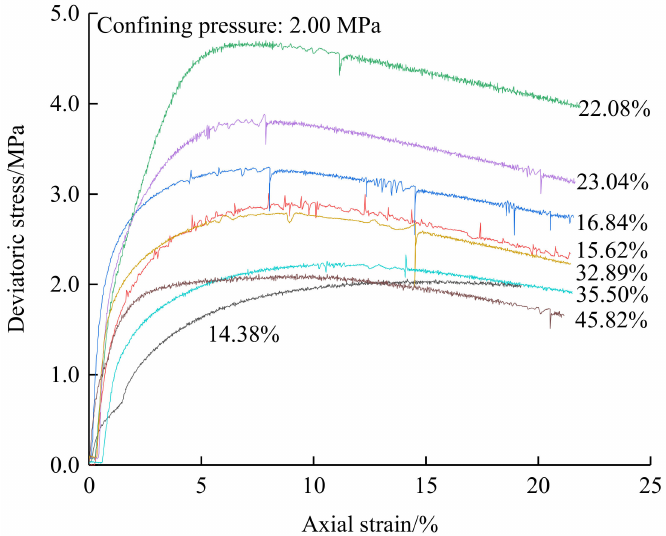
Figure 4. Stress-strain curves for samples with different levels of water content (different colors of curves correspond to samples with different levels of water